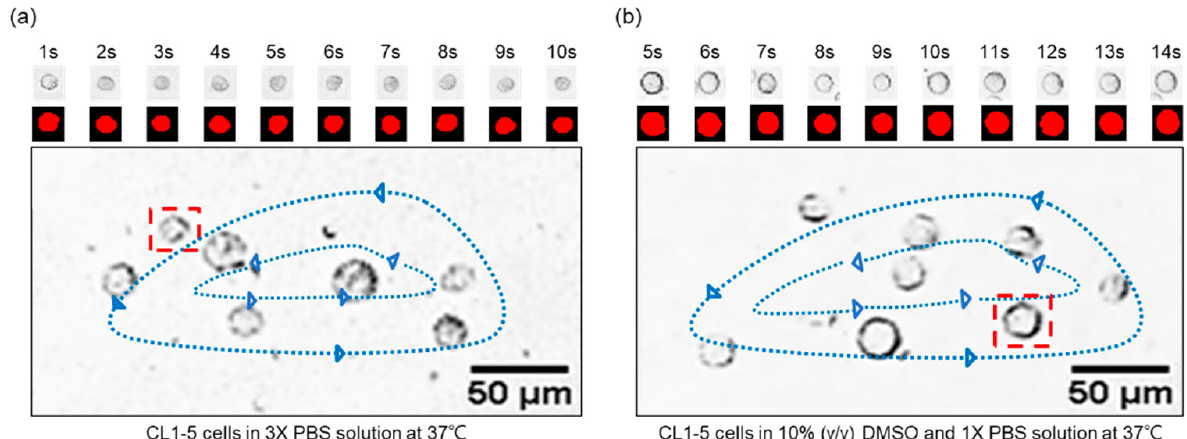
Figure 3. The CL1-5 transient volume change from the footages of the cells circulating in a vortex of ( a ) 3 × PBS solution, and ( b ) 10% ( v / v ) DMSO and 1 × PBS solution. The ambient temperature is controlled at 37 ◦ C, and a one-second interval is selected to generate a sequence of images that demonstrate the trend of volume variations. Please note that the sequential images shown in the figure present only the selected part of the recorded video for demonstration purposes.